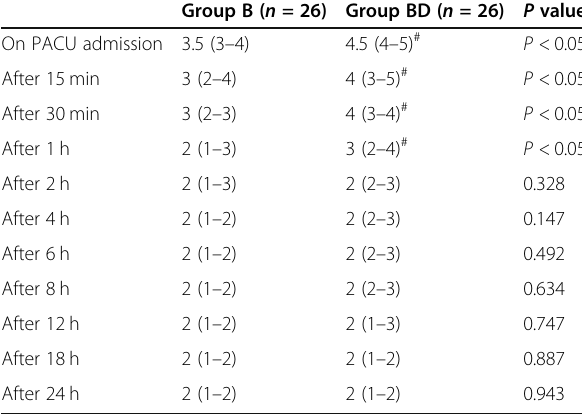
Table 8 Postoperative sedation